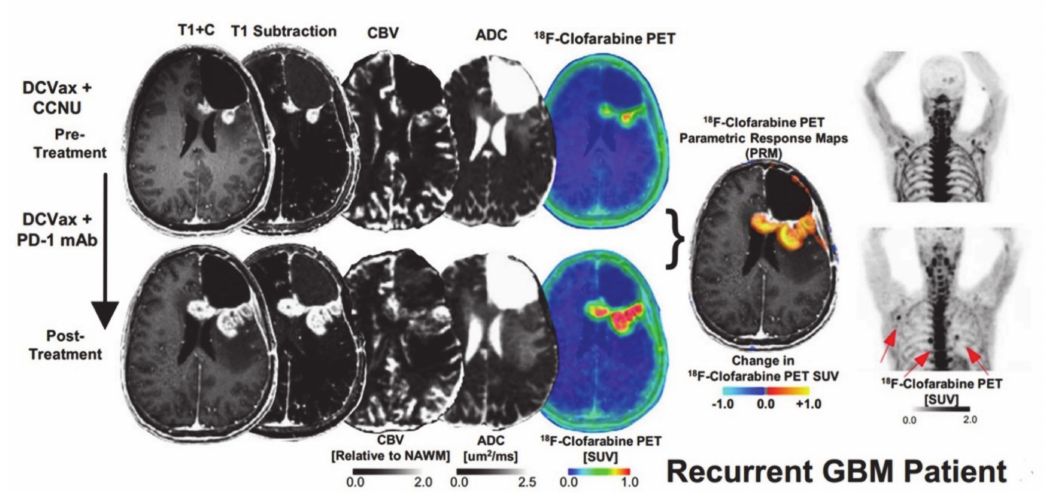
Figure 10. Post-contrast T1 weighted, T1-subtraction, rCBV, ADC, [ 18 F]-FAC PET + MRI fusion and whole-body maximum intensity projection images of [ 18 F]-CFA from a patient with recurrent GBM before (top) and after (bottom) immunotherapy are shown. Reprinted with permission from ref. [114].